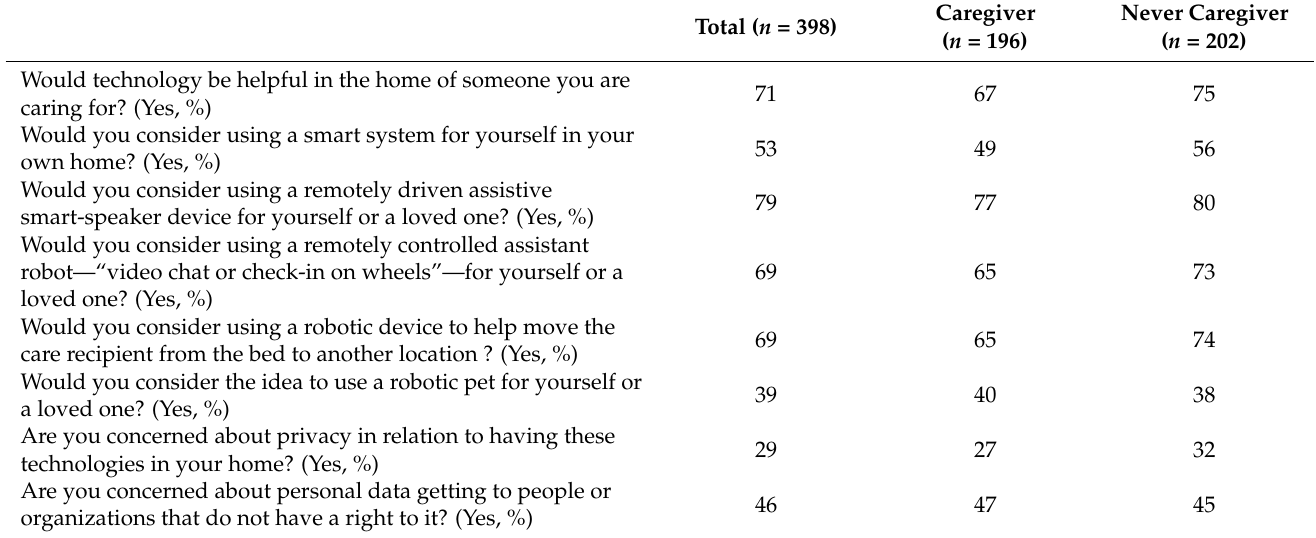
Table 3. Main attitudes about in-home smart technologies among those who have and have not ever considered themselves as an un-paid